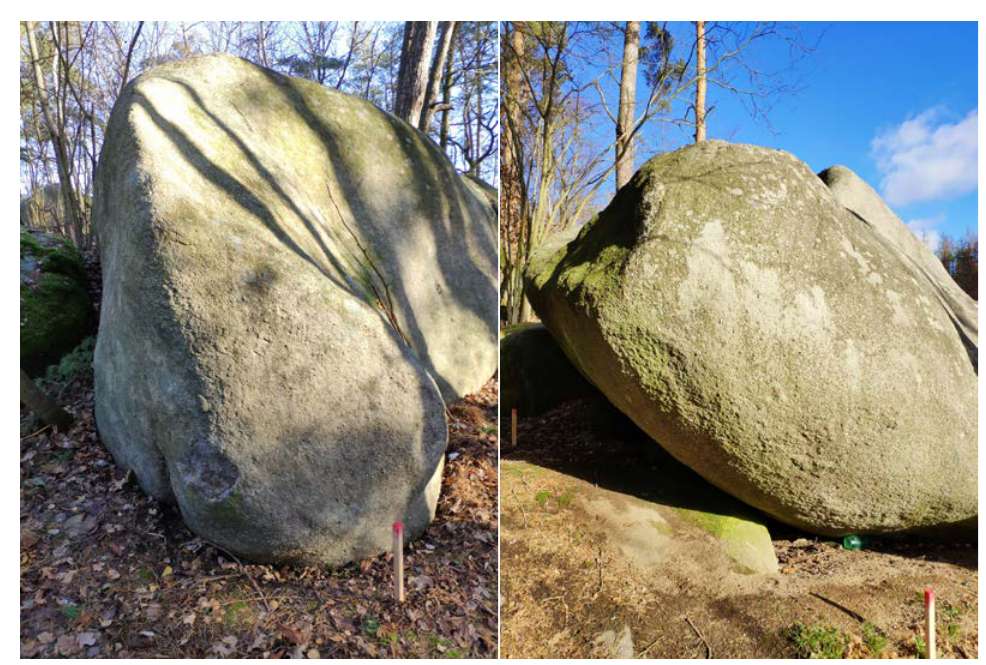
Figure 3. Boulder No. 1 (left) and boulder No. 2 (right) with visible wooden control points.